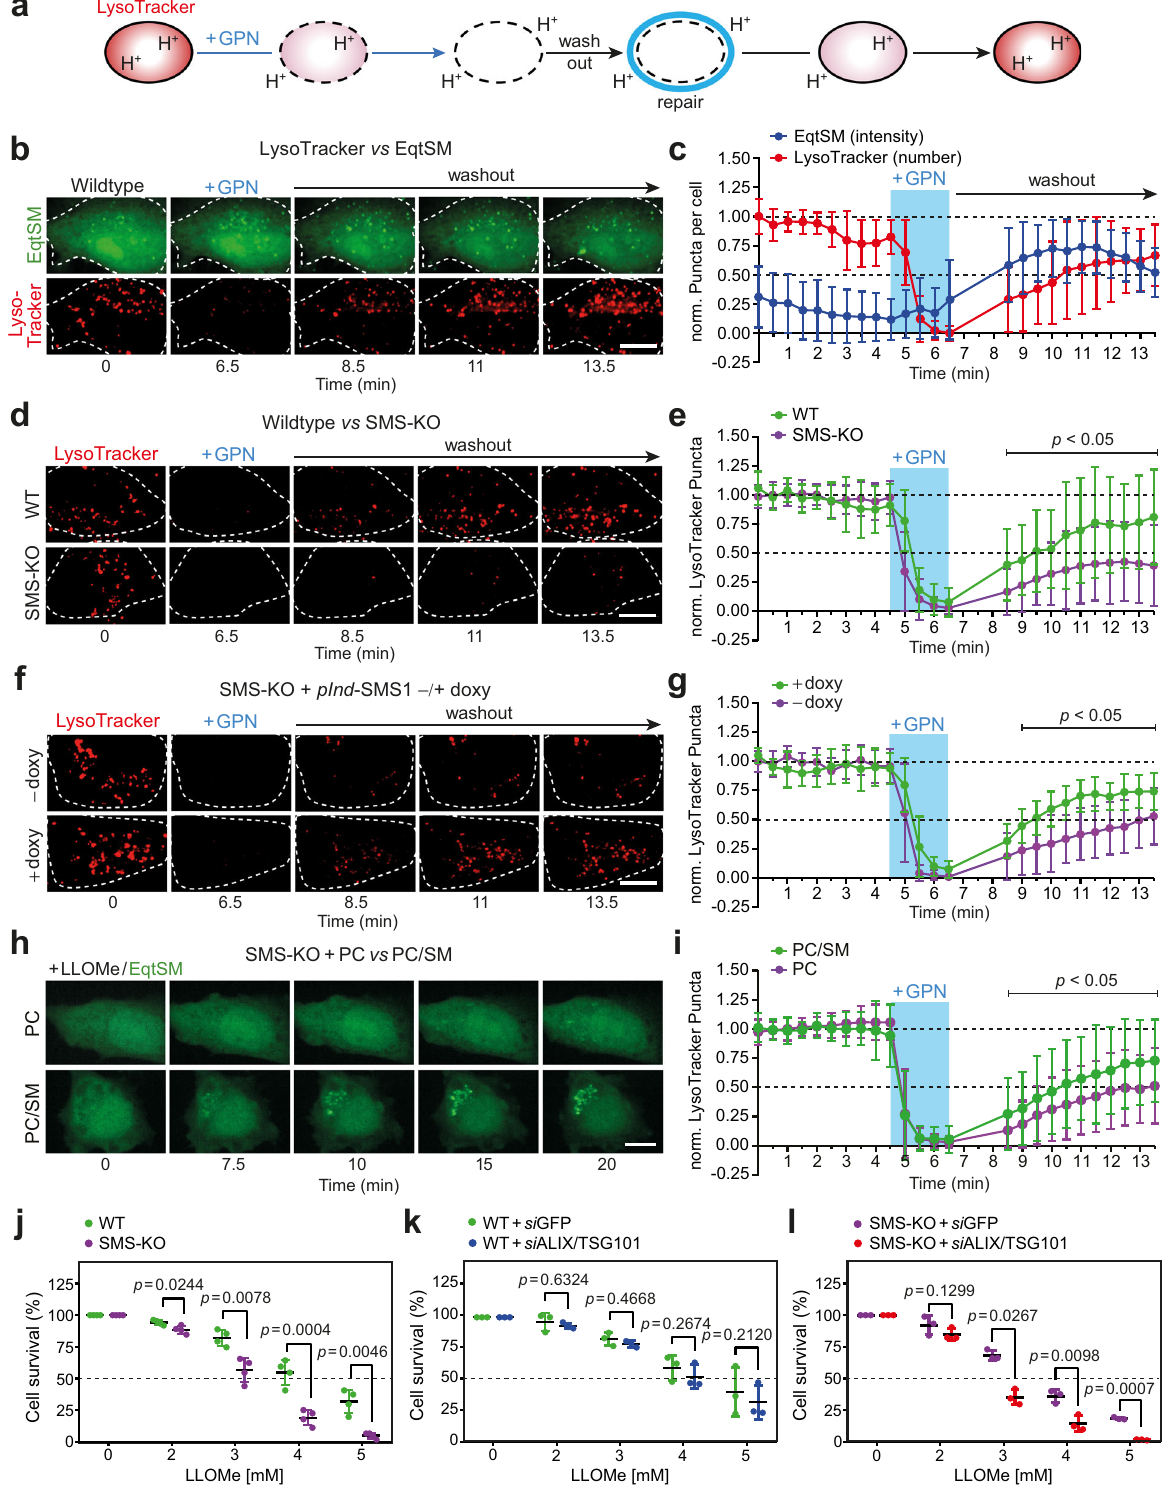
cells (Fig. 7g, h). This indicates that nSMase-2 is a critical com- ponent of an SM-dependent membrane repair pathway for the restoration of damaged